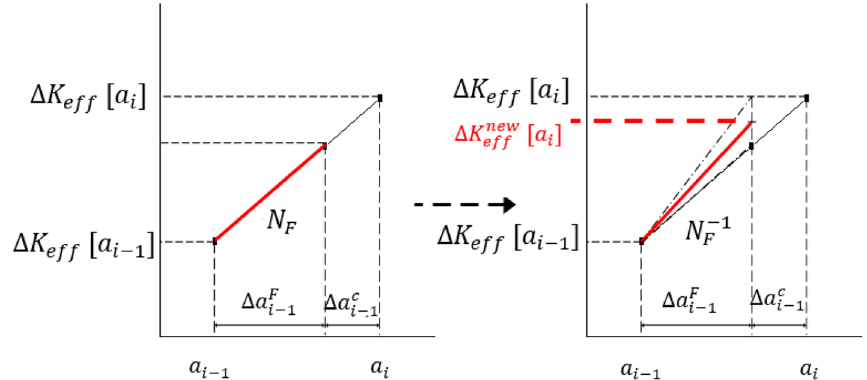
Fig. 2 Modification of effective stress intensity factor